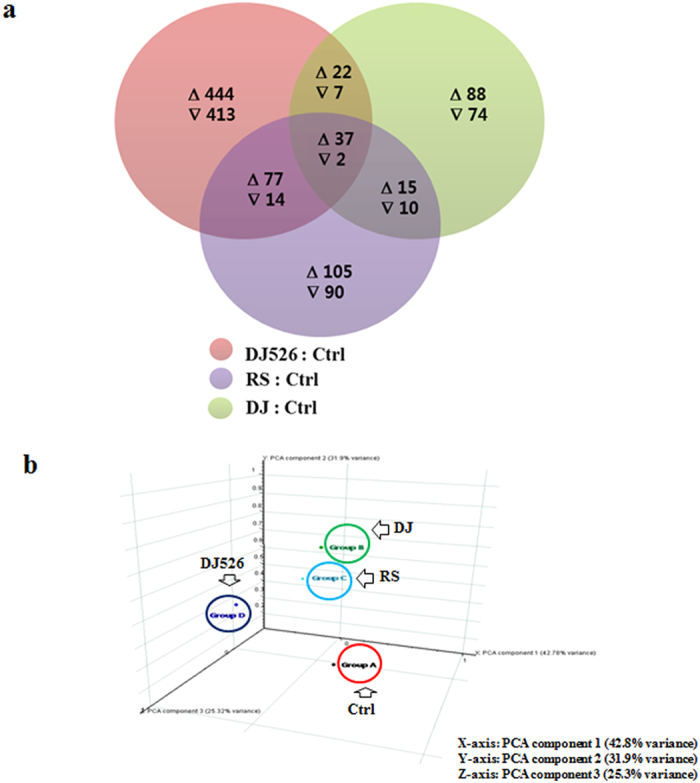
The gene expression patterns of the mice on resveratrol (RS), Dongjin rice (DJ), resveratrol-enriched rice DJ526 (DJ526), or control (Ctrl) diet.The control (Ctrl) mice fed a NFD in which the carbohydrate source was corn starch and sucrose; The resveratrol (RS) mice fed a NFD in which the carbohydrate source was corn starch and sucrose except containing resveratrol; Dongjin (DJ) mice fed a NFD in which the corn starch and sucrose were replaced with Dongjin rice; DJ526, mice fed a NFD in which the corn starch and sucrose were replaced with the resveratrol enriched rice DJ526. The resveratrol concentration in DJ526 and RS groups was 0.69 μg/g each, and not detected in Ctrl and DJ groups. (a) Overlaps of differential expression signatures at the end of 6 month feeding experiments. A total of 1016 probe sets (<2.6%) were induced by DJ526/Ctrl, while 255 probe sets (<0.7%) were induced by DJ/Ctrl and 350 probe sets (<0.9%) were induced by RS/Ctrl. The Venn diagram shows the overlap between these groups, where up and down triangles indicate the number of probe sets up and down-regulated, respectively. Genes were filtered using a cutoff Z-ratio ± 1.5 and p-value of <0.05. (b) Principal component analysis of the microarray data at the end of the 6 month feeding experiments. The first principal component (PC1) is dominant with 42.8% variability, and shows that DJ526 is different from DJ, RS, or Ctrl, respectively.